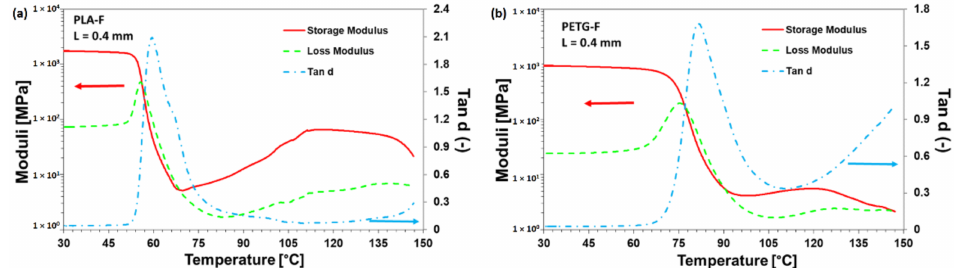
Figure 10. DMTA tests on ( a ) PLA-F and ( b )